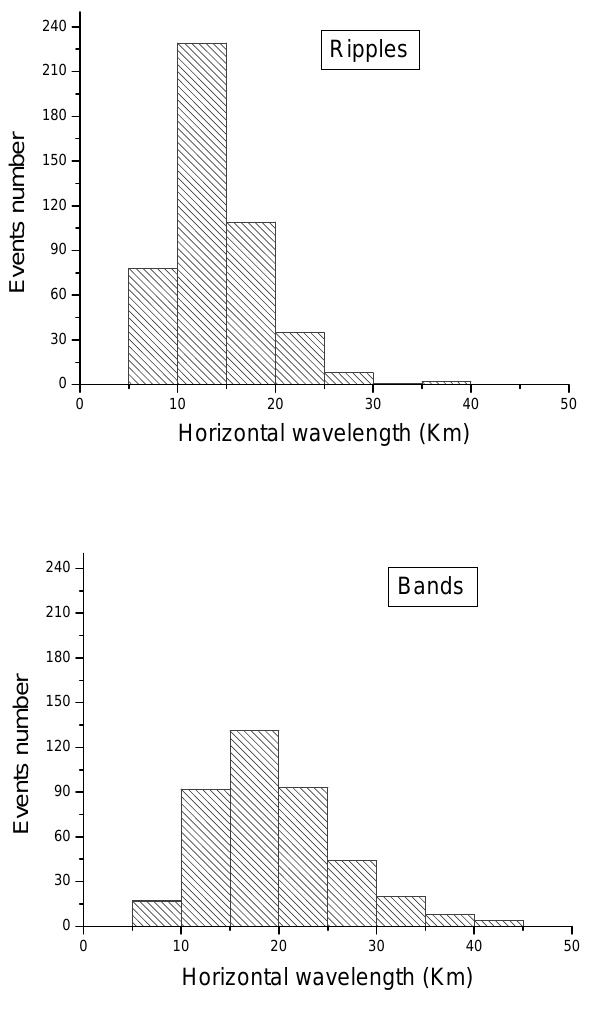
Fig. 3. Histogram of the horizontal wavelength for bands and rip- ples binned in 5-km intervals. Fig. 4 - Histogram of the observed period for bands and ripples binned in 2 min Fig. 3 - Histogram of the horizontal wavelength for bands and ripples binned in 5 km intervals.